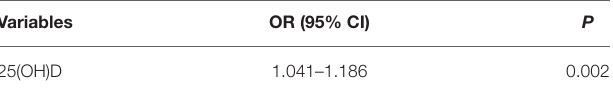
TABLE 2 | Multiple logistic regression analysis to identify independent risk factors for residual dizziness after successful treatment of